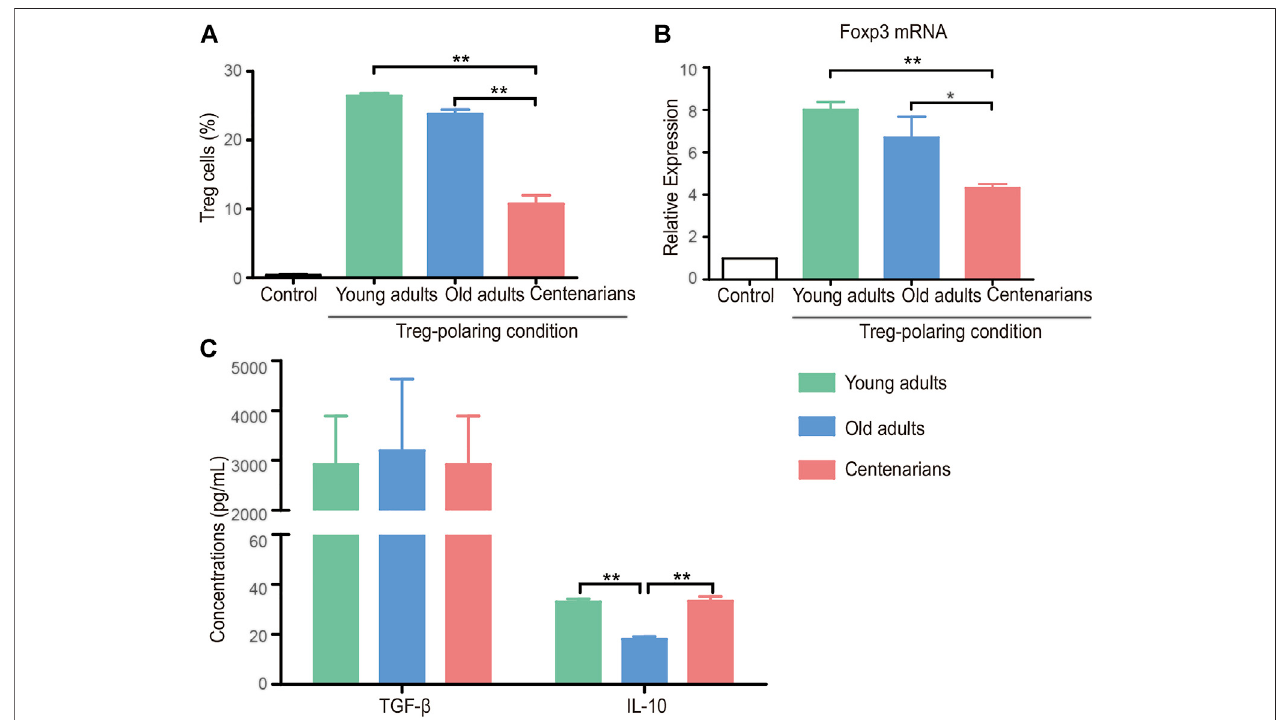
FIGURE 4 | Decreased Treg cells in centenarians secreted more anti-in fl ammatory cytokines in vitro . Naive CD4 + T cells from young adults, old adults and centenarians were stimulated with immobilized anti-CD3 and anti-CD28 monoclonal antibodies under Treg-polarizing conditions for 5 days in vitro . (A) Treg cells were measuredbyFCM. (B) Foxp3mRNAlevelsweredeterminedbyqPCRinTreg-polarizingconditions. (C) ThesupernatantsinTreg-polarizingconditionswerecollectedto detect the levels of TGF- β and IL-10 by ELISA. Data were expressed as the mean ± SD. n = 8. Asterisks (*) indicate signi fi cant differences (* p < 0.05; ** p <